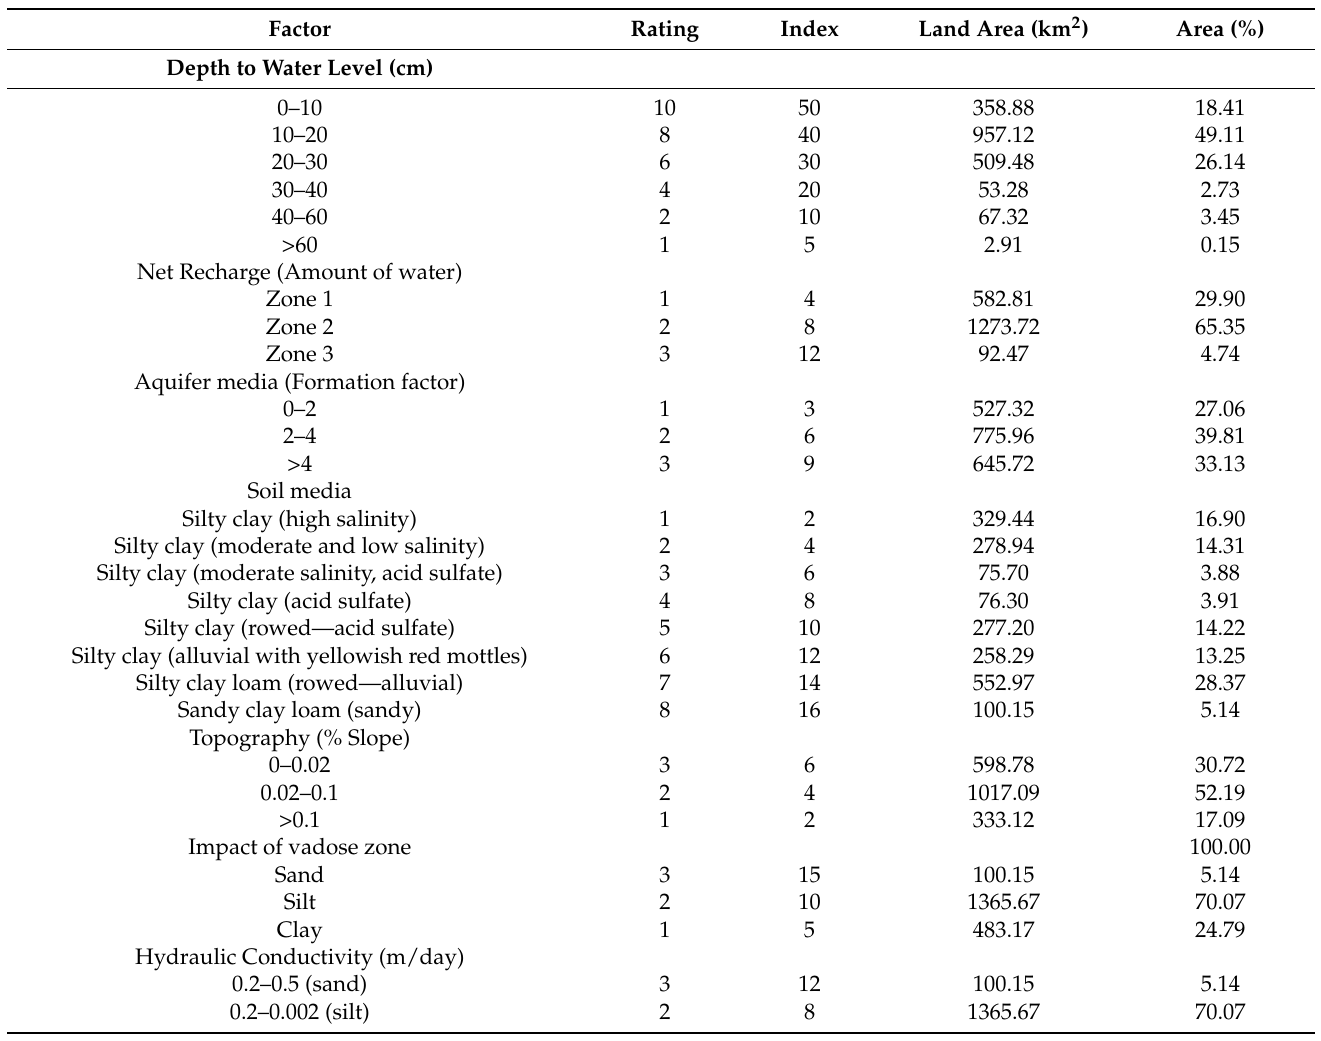
Table 3. Adjusted DRASTIC factor default ratings ( R i ) used to predict the soil water’s vulnerability to salinization in the study